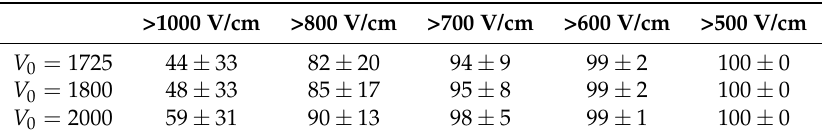
Table 6. Ablation zones percentage. Table shows percentage of tumor above a given electrical field strength from varying σ 0 for the tumor.